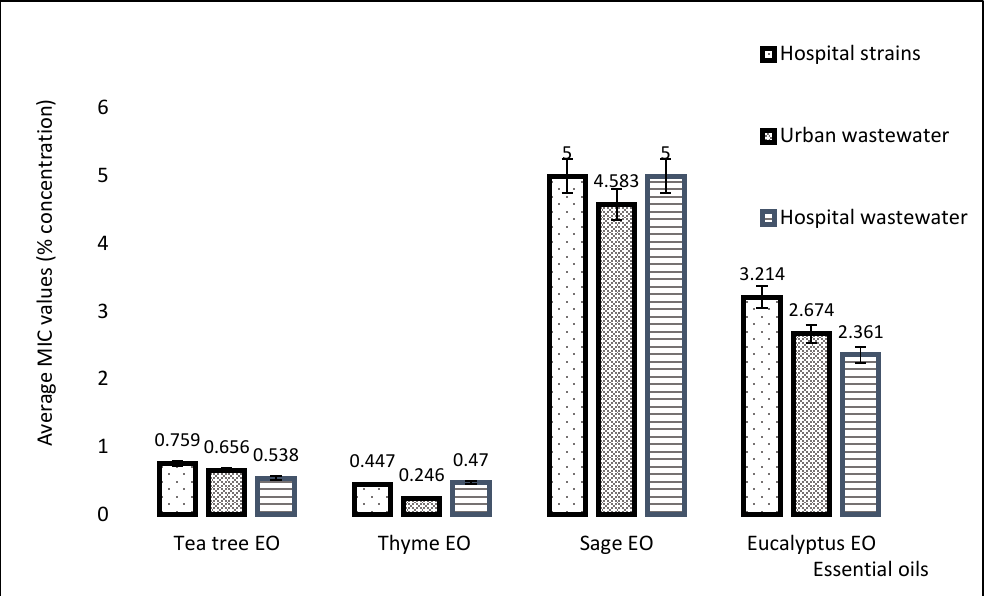
Figure 11. Comparison of the MBICs of thyme and tea tree EOs in P. aeruginosa strains depending on their isolation source.